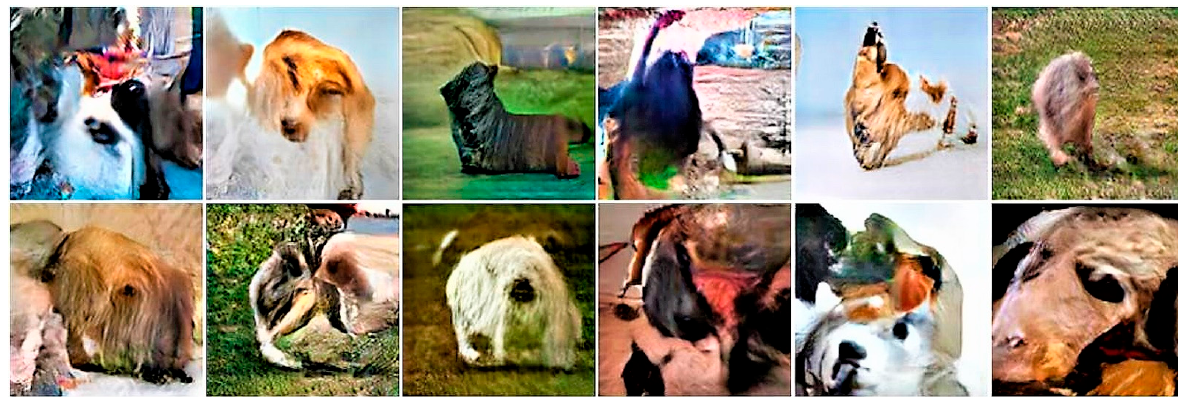
Figure 9. The generated ImageNet outputs that show how 256 × 256 images are generated using EBGAN with Pull-away